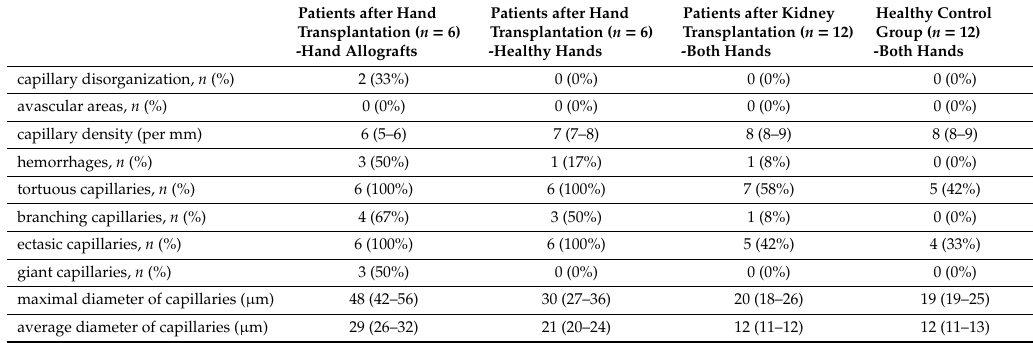
Table 2. Patients’ characteristics.